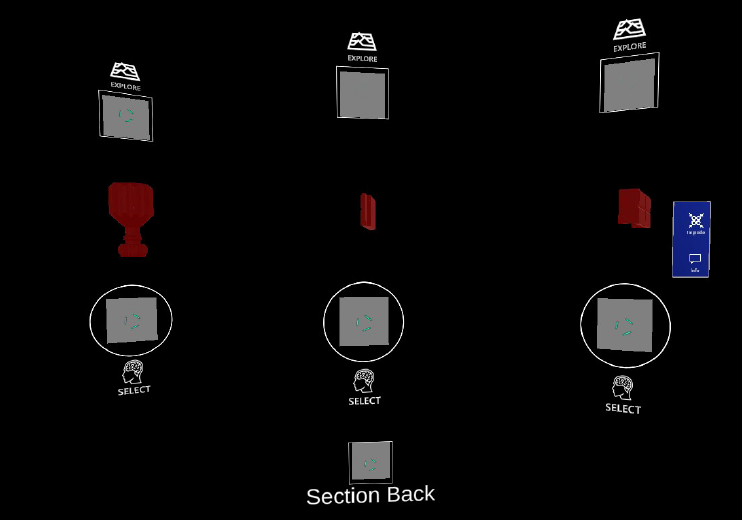
Figure 6. All parts of the first section are displayed; each part is associated with two NeuroTags.